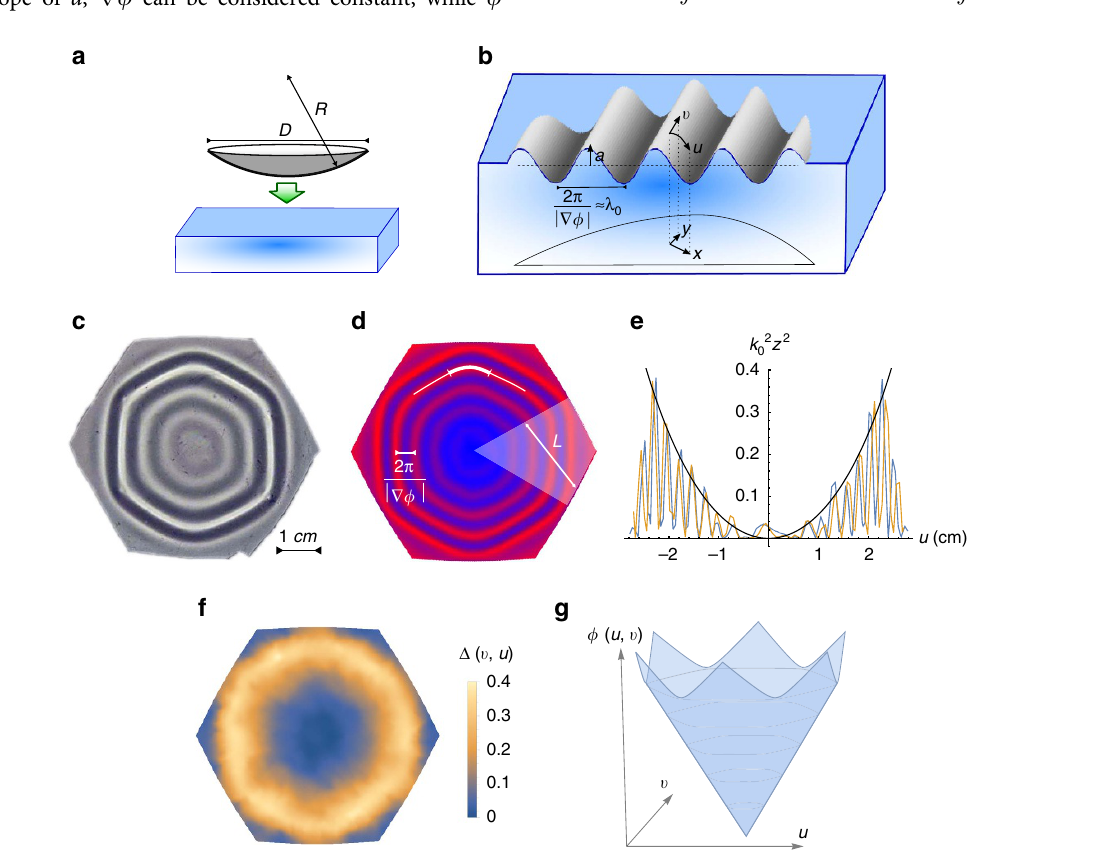
Figure 2 | Non-Euclidean shells on a Euclidean substrate. ( a ) A spherical shell laid atop a flat body of water may develop wrinkles as means to overcome the geometric incompatibility. We denote by D the typical size of the shell and by R its radius of curvature. ( b ) We choose coordinates { u , v }, which at large scales follow the Cartesian coordinates { x , y } of the projection, however, at sub-wrinkle scales are proportional to arclength coordinates on the sheet. The amplitude a ( u , v ) and wave vector 2 p (written as in terms of a phase field f ( u , v )) may significantly vary across the sheet, however, the wavelength 2 p has r f r f j j a universal preferred value l 0 . ( c ) Experiment: a hexagonal D ¼ 6cm patch was cut out of a 30 m m-thick PDMS spherical shell, R ¼ 6cm, before laid atop water. Shown is a top view schlieren image of the equilibrium configuration. ( d ) Simulation: a finite-element code with the physical parameters of the experiment ( c ). Shown is the vertical displacement from the plane. A single wrinkle (solid line) may bend, that is, change its in-plane direction, with wrinkle curvature encoded in the second derivatives of the phase field f . In the shown example, the obtained pattern breaks into six domains, such as the lightened region on the right. Wrinkle bending focuses into domain walls (thicker solid segment of the wrinkle line). We denote by L the typical domain size. ( e ) The height squared profile of ( d ), at two different slices (horizontal and vertical), normalized by k 2 . The envelope of these curves is by definition D ( u , v ). The 0 , plotted for R ¼ 6cm (no fitted parameters), is anticipated for an axisymmetric pattern. ( f ) The full D ( u , v ) measured from ( d ). black curve, D ¼ 2 u 2 R 2 (cid:2) u 2 ( g ) Sketch of the phase field f ( u , v ) for the pattern in ( c , d ). Level sets of f indicate